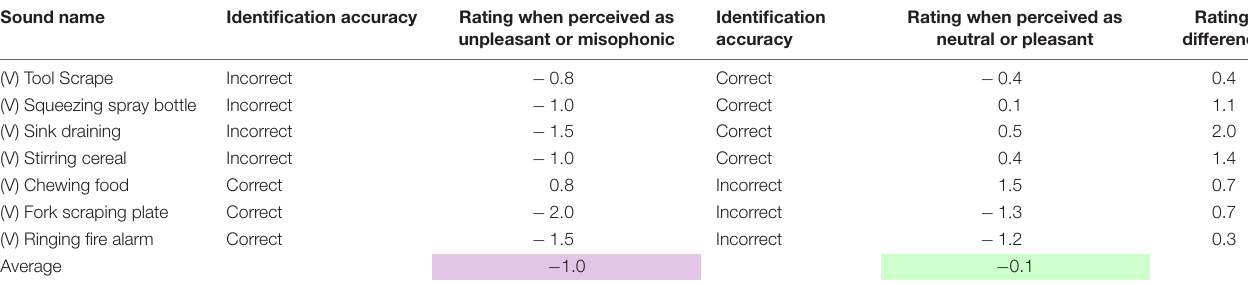
TABLE 7 | Mean pleasantness ratings for the most frequently misidentified sounds in Experiment 2 as a function of how they are identified.